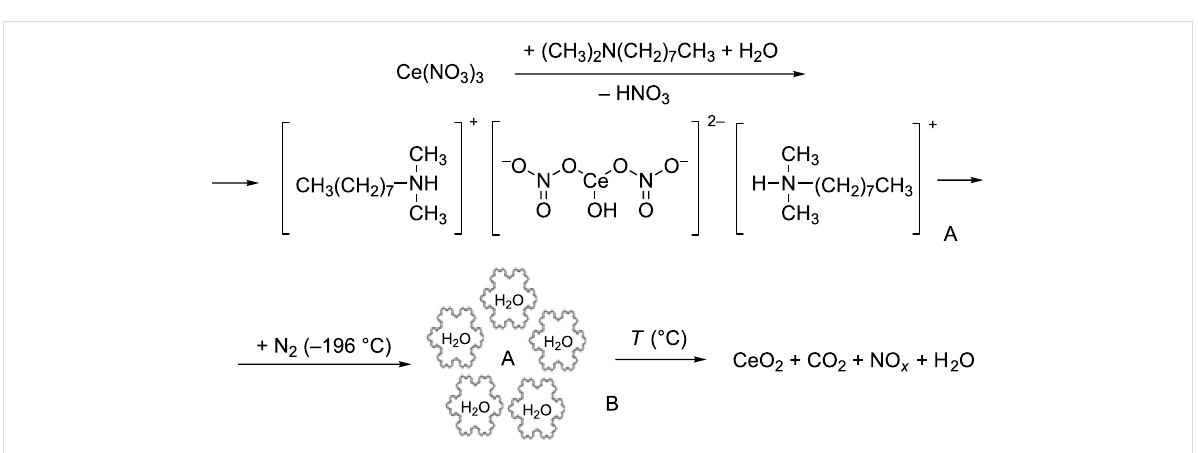
Figure 3: Scheme of CeO 2 nanoparticle formation, including the cryotreatment step (liquid N 2 , − 196 °C ) on the as-prepared sol. A is the sol interme- diate formed from the interaction of hydrolyzed Ce 3+ ions with DMOA. B is the cryogel formed from the interaction of liquid nitrogen with A.